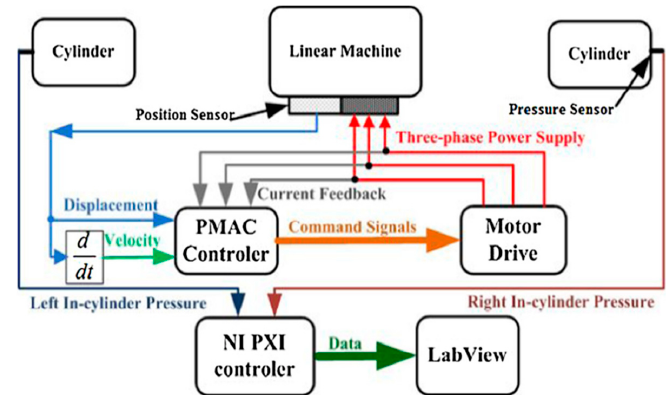
Figure 18. Control system block diagram for the setup at Beijing Institute of Technology [46].